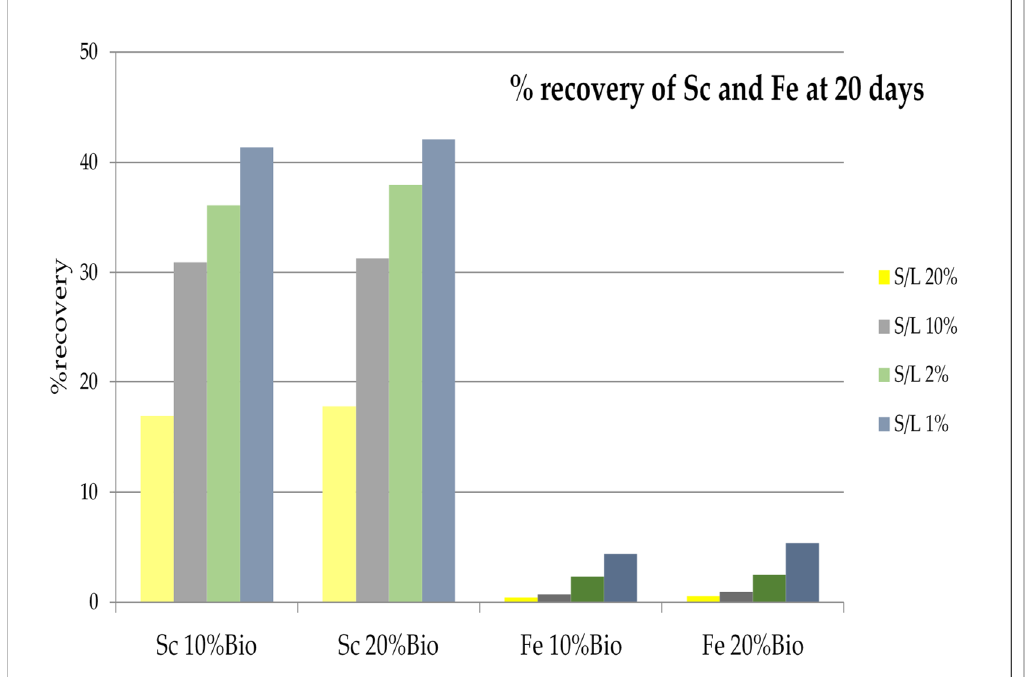
Figure 2. Sc and Fe recovery by Acetobacter tropicalis in bioleaching experiments of 1, 2, 10, and 20% S/L- pulp density of BR with 10 and 20% w / w of bacterium suspension on the 20th day .